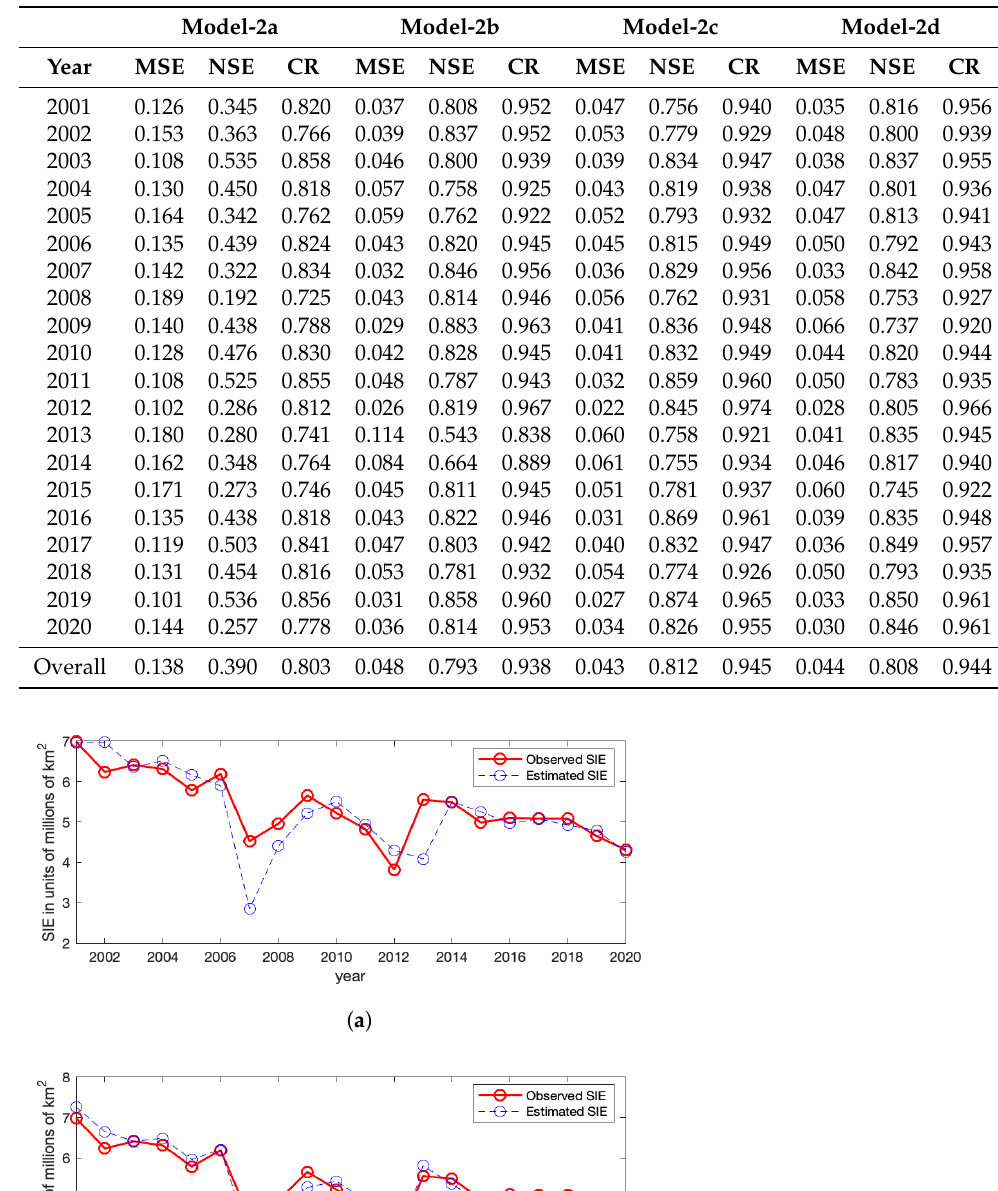
Table A3. The MSEs, NSEs, and CRs for the Model-2 class with clear-sky RSR (CS-RSR) as a covariate. The last row gives the time-averaged model evaluation scores.